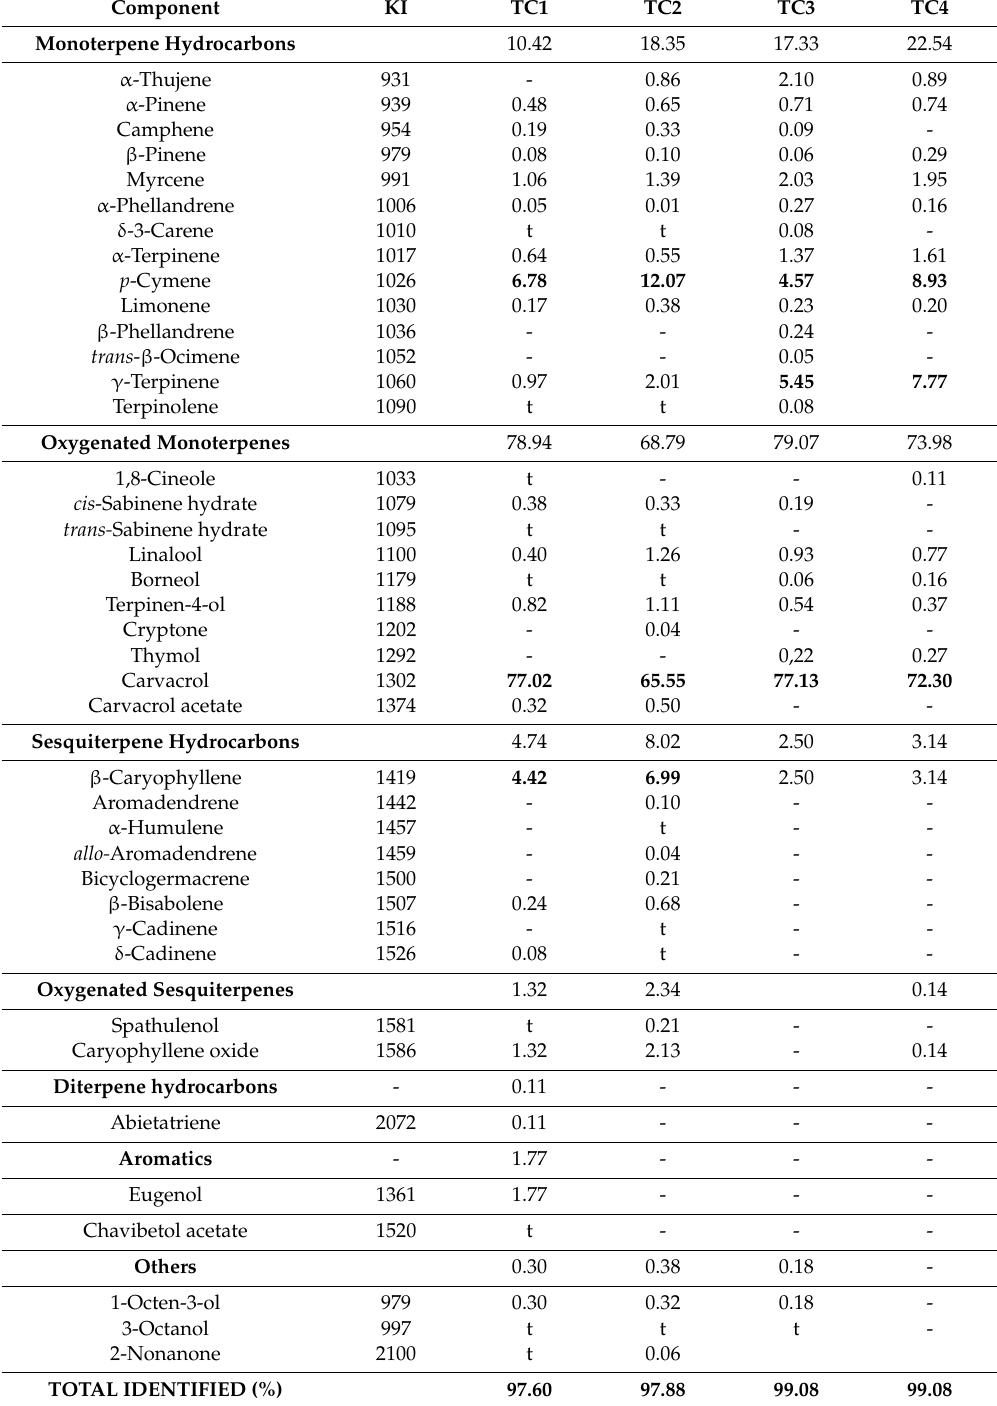
Table 1. Chemical composition of Thymbra capitata EOs tested. TC1 , T. capitata from Enna (Enna province, Sicily) collected at flowering stage, TC2 , T. capitata from Riesi (Caltanissetta province, Sicily) collected at vegetative stage. TC3 , T. capitata from Carmona (Seville province, Spain) collected at flowering stage. TC4 , EO purchased from Bordas, S.A. (Seville province,